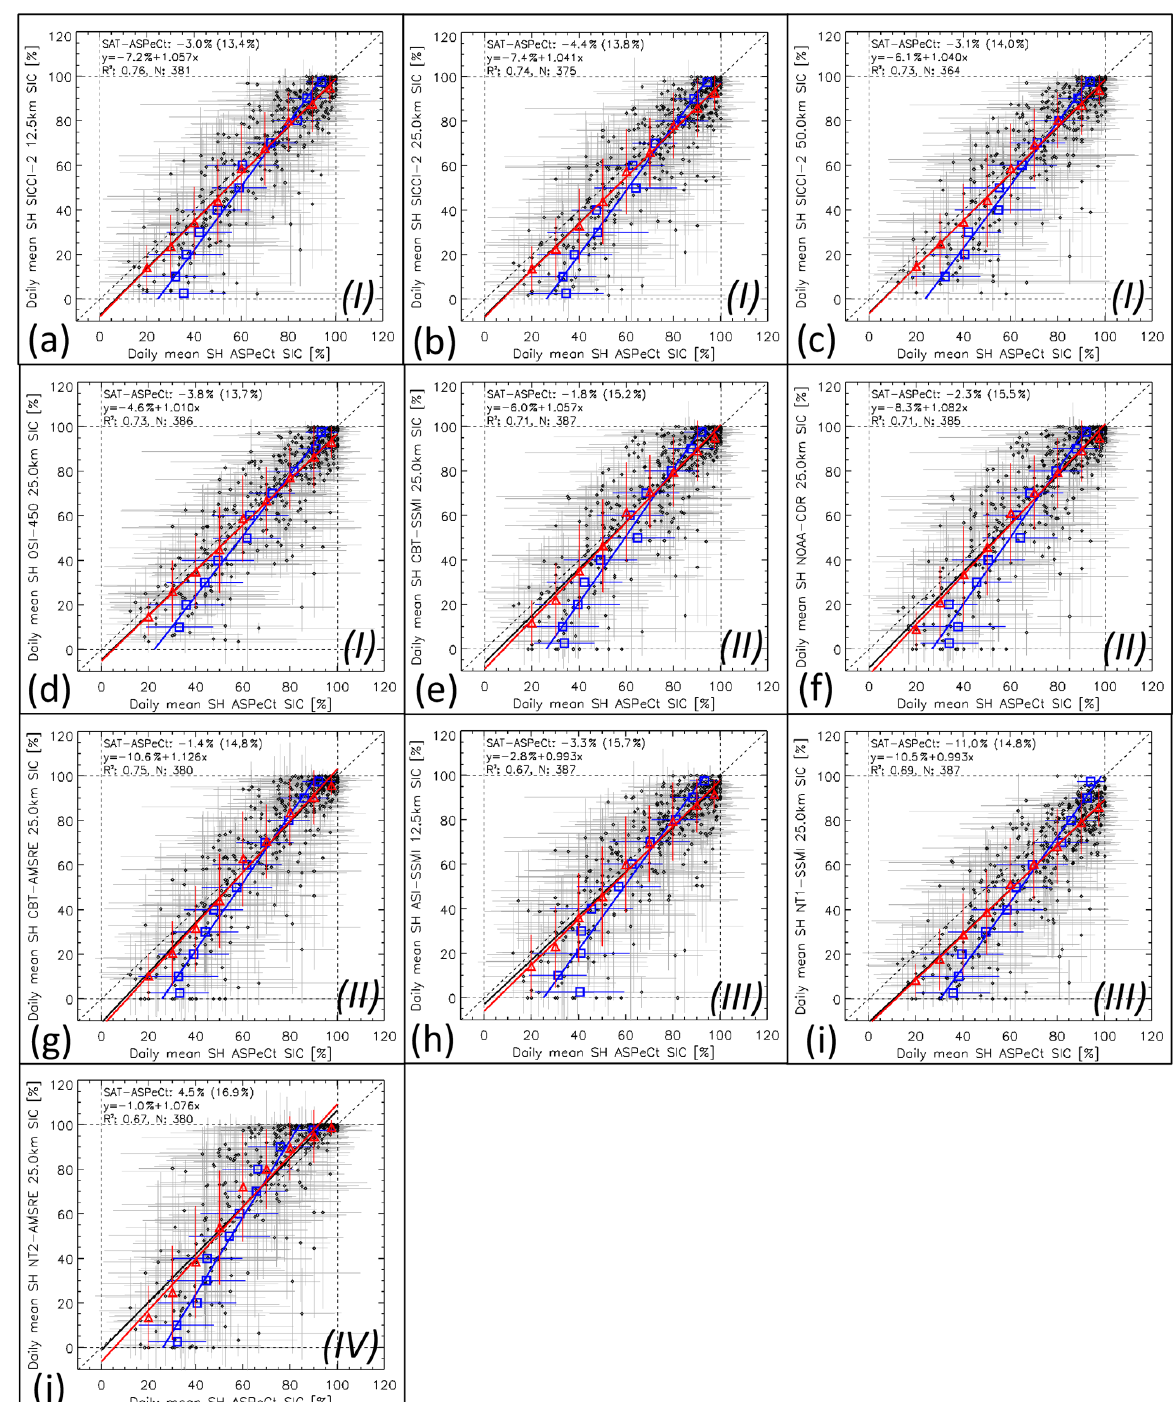
Figure 16. As Fig. 15 but for the Antarctic.